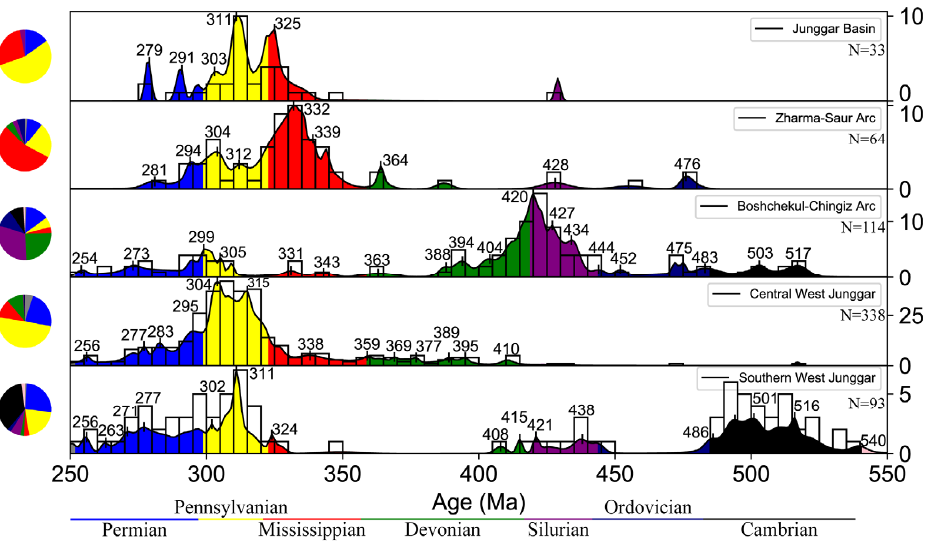
Figure 7. Zircon age distributions of magmatic and metamorphic rocks in northern West Junggar (NWJ), including the Zharma-Saur arc and Boshchekul-Chingiz arc, central West Junggar (CWJ), southern West Junggar (SWJ), and the Junggar Basin, shown as histograms, probability density plots, and pie charts. Data from Xu et al. [31], Chen et al. [40], Yang et al. [45], Li et al. [80], Li et al.